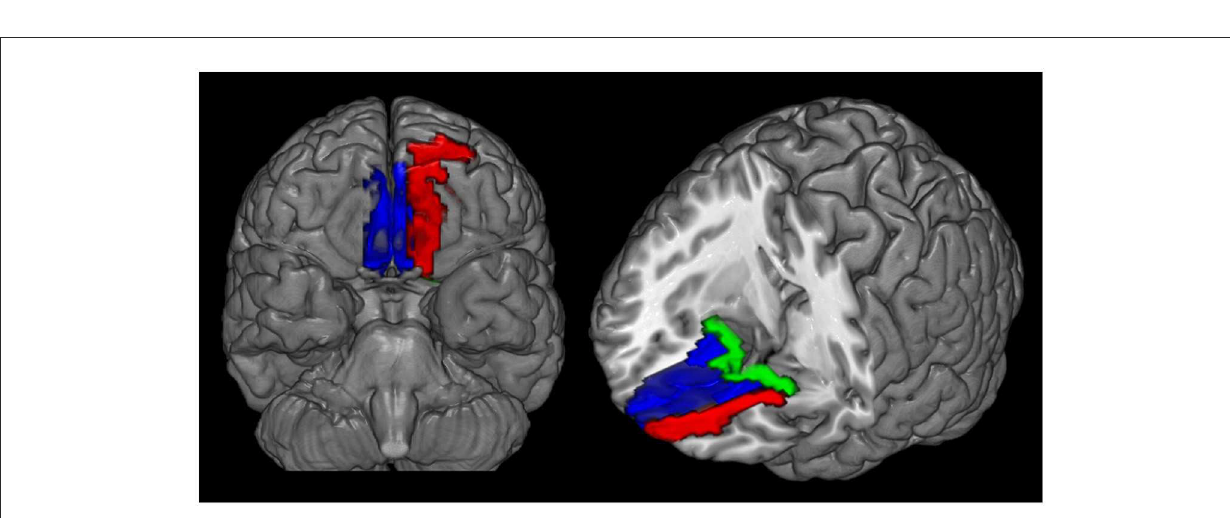
FIGURE5 Decreased ReHo–CBF connectivity located in the left orbital region of the superior frontal gyrus (red region), the bilateral gyrus rectus (blue region), and the olfactory cortex (green region) in patients with medication-overuse headache (MOH) compared with normal controls